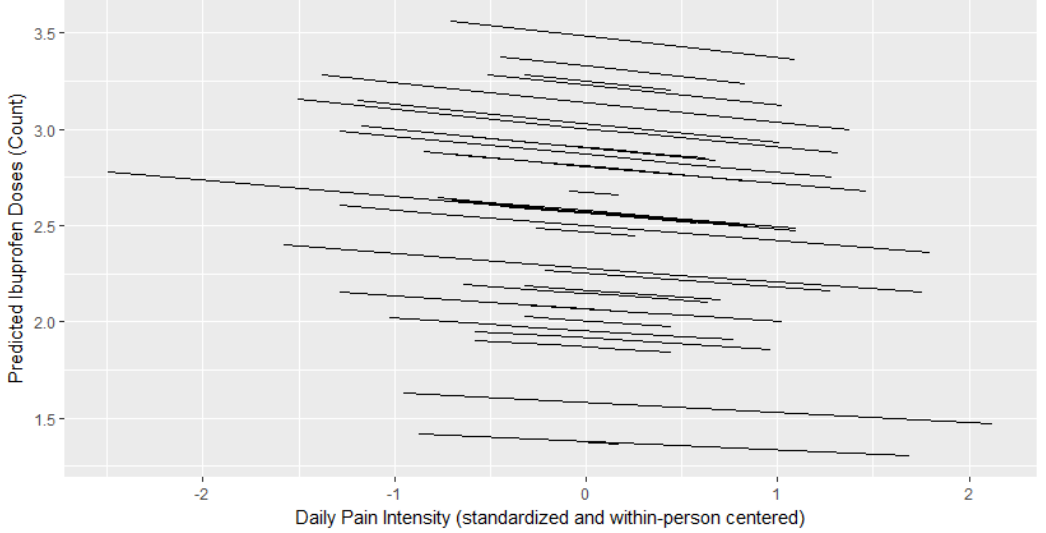
Figure 3. Within-person relationship between a child’s daily pain intensity and predicted ibuprofen doses administered. Daily Pain Intensity is within-person centered where a higher score indicates greater pain intensity on a given day compared to a child’s average across the postoperative period. Parental CAM Attitudes were associated with the likelihood of administering oxycodone 3.43.63.844.24.44.64.85 post-tonsillectomy, as well as with the number of doses given. Parents who did not administer any oxycodone, when compared to parents who administered at least one dose, reported significantly more positive CAM attitudes, mean = 3.98 (SD: 0.60) vs. mean = 3.57 (SD: 0.47), respectively (t(31) = 2.21, p = 0.04, Cohen’s d = 0.76; Figure 4). More positive CAM attitudes predicted fewer doses of administered oxycodone (b = − 1.192, p = 0.004), above and beyond the medication variations that could be accounted for by daily pain intensity and average postoperative